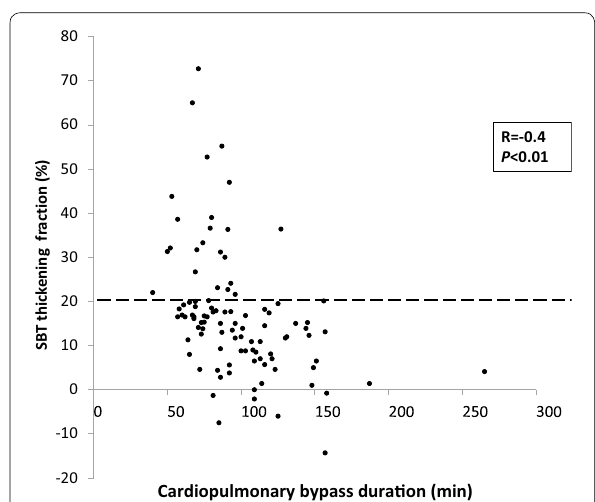
Cardiopulmonary bypass dura(cid:3)on (min) Fig. 4 Individual values of diaphragm thickening fraction according to cardiopulmonary bypass duration. The diaphragm thickening fraction (TF) during the spontaneous breathing trial (SBT) was recorded according to the Y, and the cross‑clamp time was recorded according to the X. Diaphragm function was reduced when cardiopulmonary bypass time was longer ( r 0.4; P < 0.0001). SBT: = − spontaneous breathing trial; TF: thickening